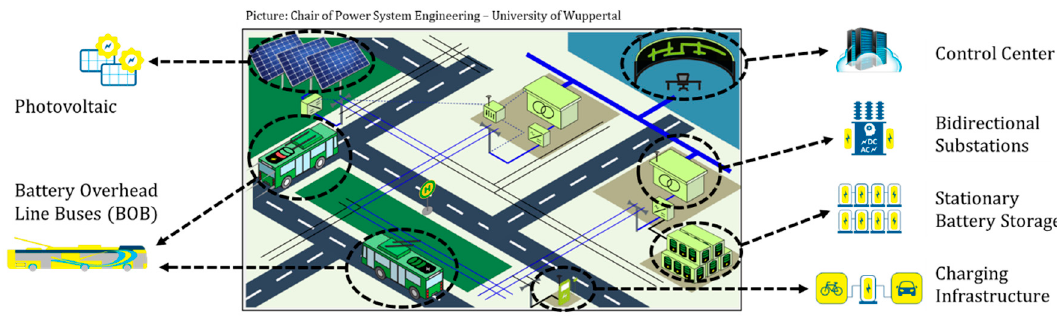
Figure 1. Schematic of the whole project.